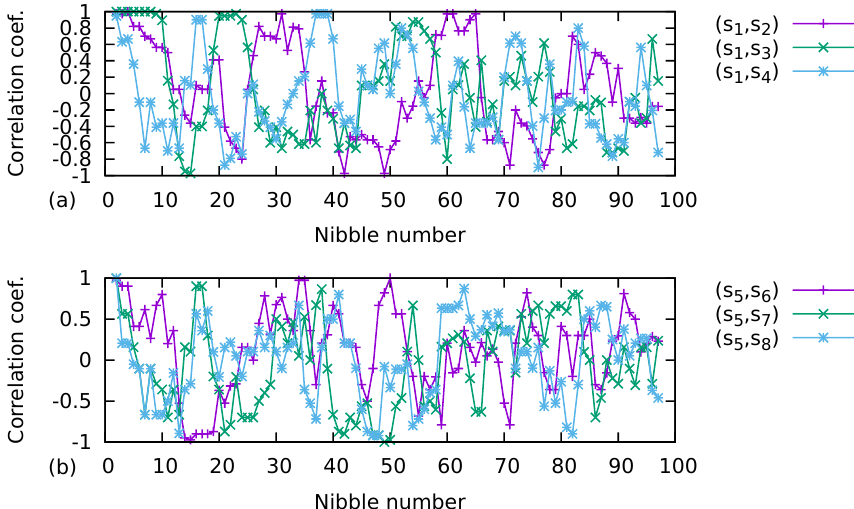
Figure 3. In ( a ) is shown the three correlations between the sequences ( s 1 , s 2 ) , ( s 1 , s 3 ) , and ( s 1 , s 4 ) , and in ( b ), between sequences ( s 5 , s 6 ) , ( s 5 , s 7 ) , and ( s 5 , s 8 ) ; by now, the value of a in Equation (1) is